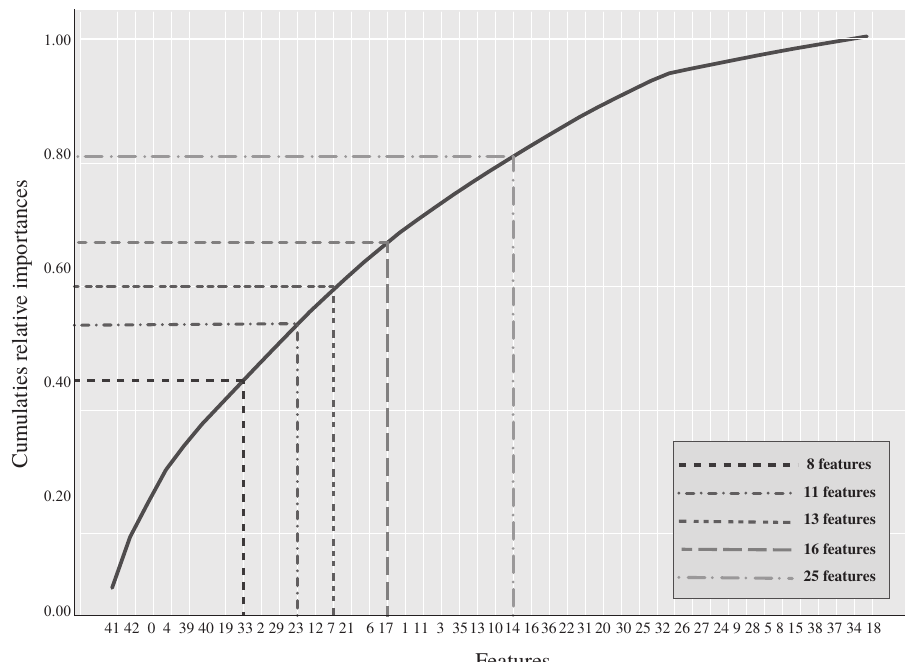
Figure 5. Features relative importance for random forest classifier using the original train